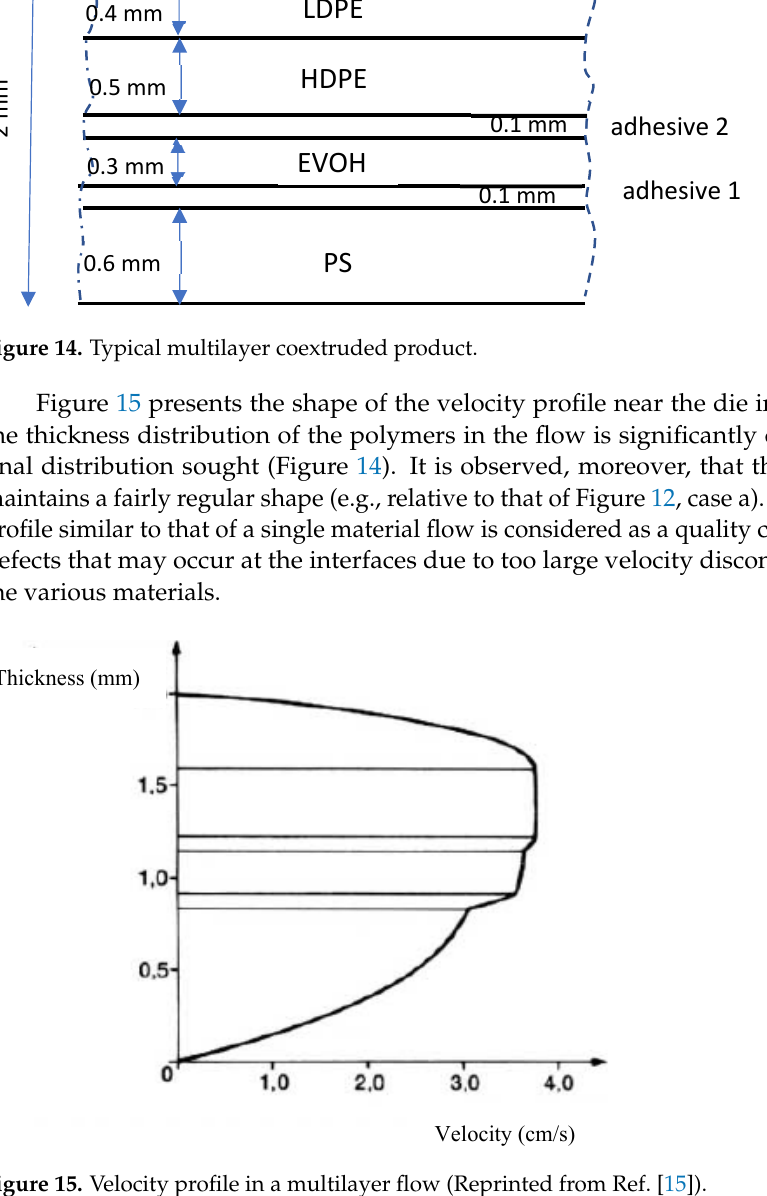
Figure 16. Variation of the interface positions along the coextrusion flow (Reprinted from Ref. [15]).